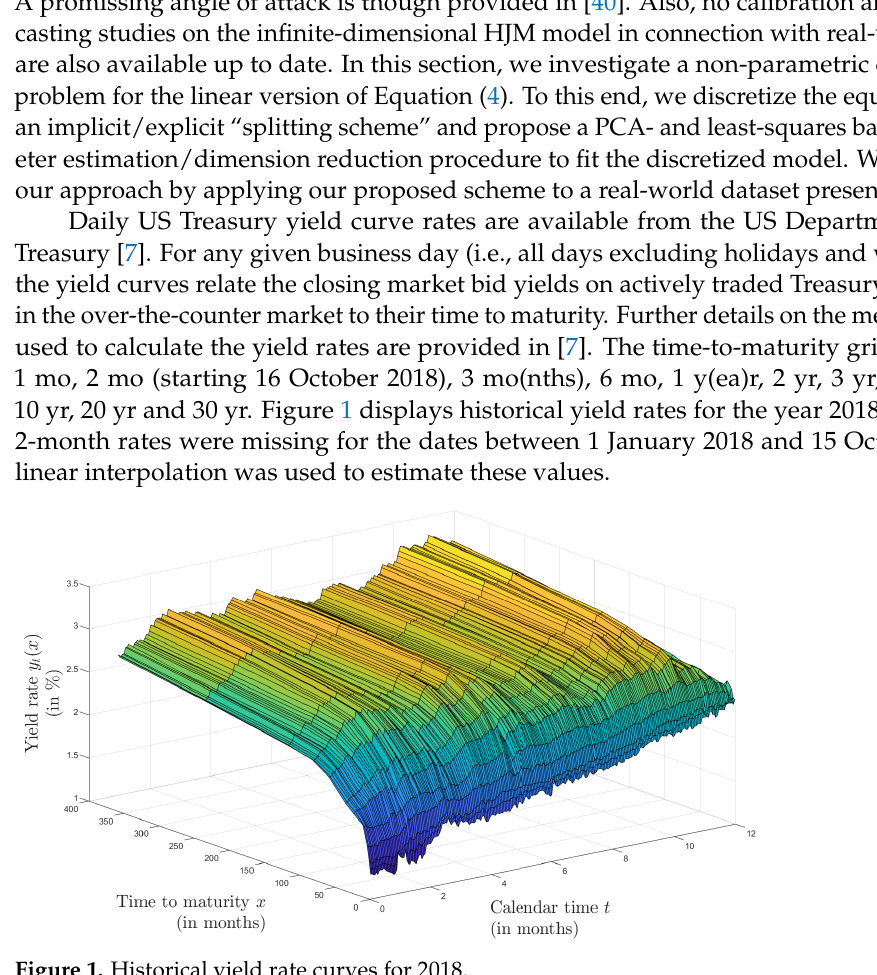
Figure 1. Historical yield rate curves for